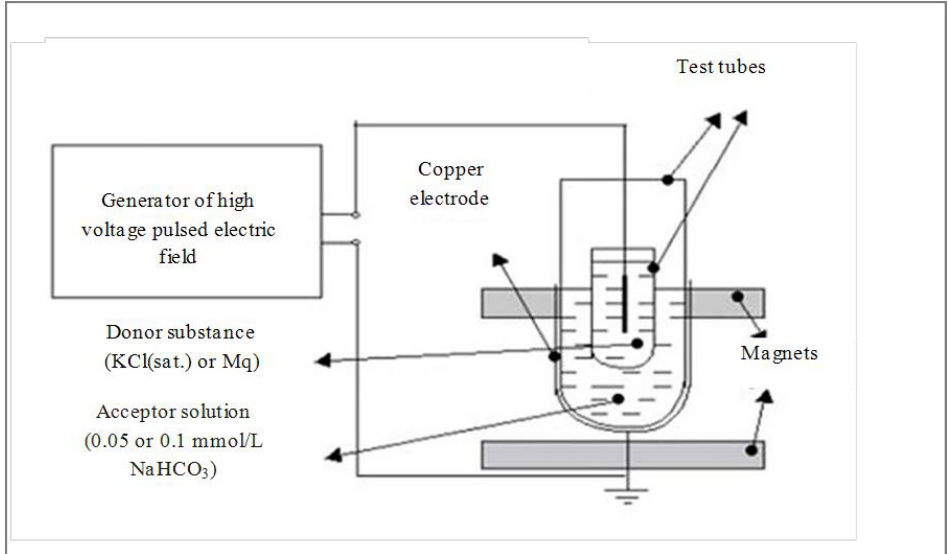
Figure 12. Scheme of electrical treatment of